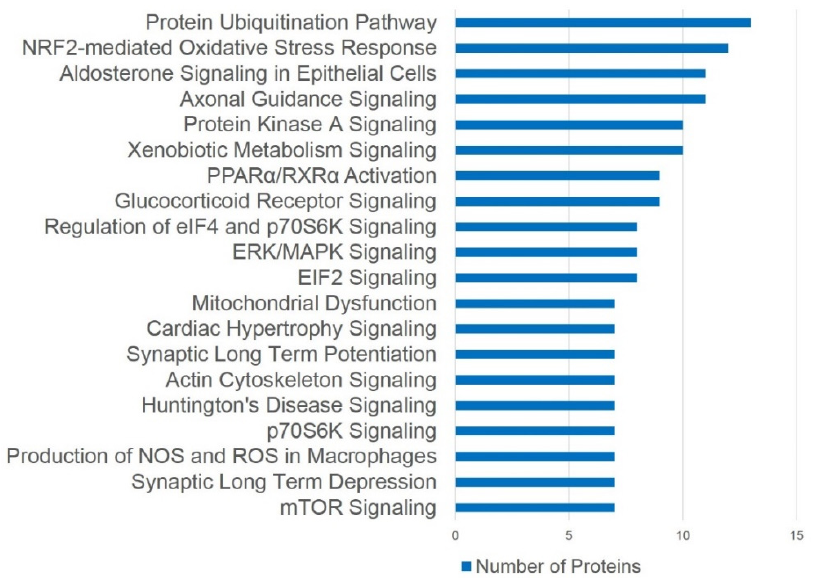
Figure 11. Canonical pathway analysis. The differentially expressed proteins ( ≥ 2.0-fold) in bladder ischemia are defined by pathway analysis using IPA software. Top 20 pathways are shown. This figure is taken from our previous publication [48].